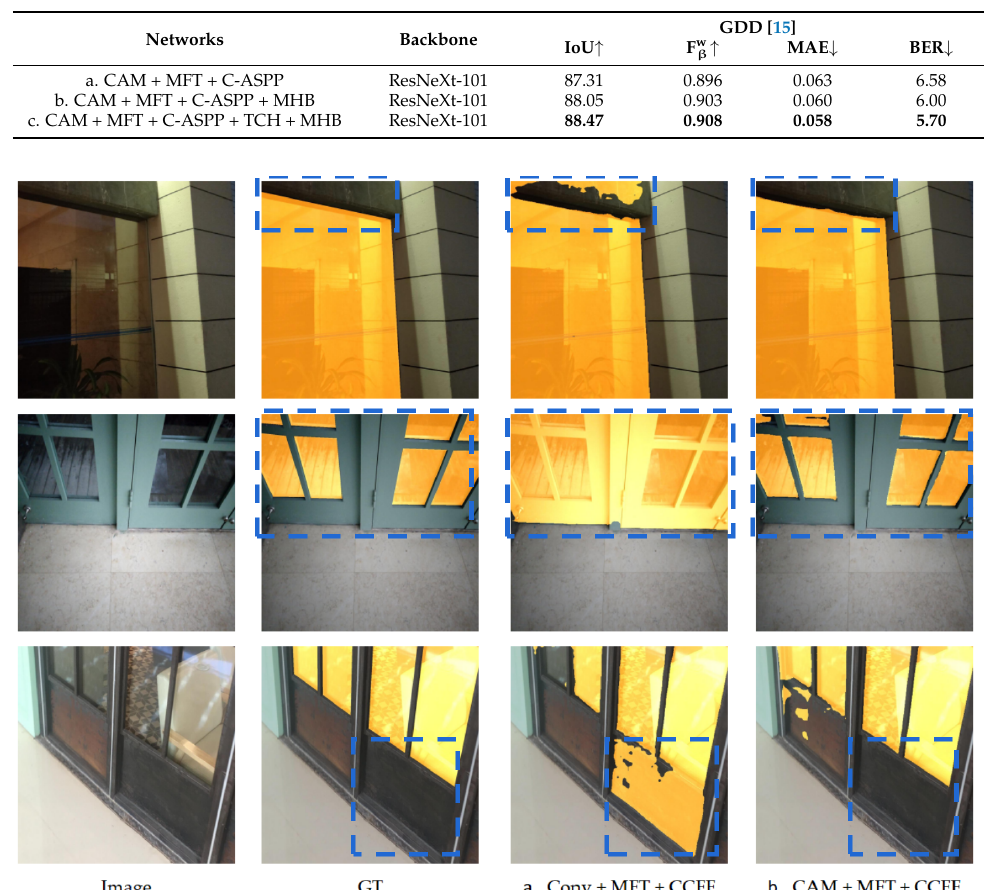
Table 6. Results of CCFF module ablation experiments; “C-ASPP,” “MHB,” and “TCH,” are the multiscale cross-modal feature extraction, fusion head block, and transformer transformation head in the CCFF module, respectively.